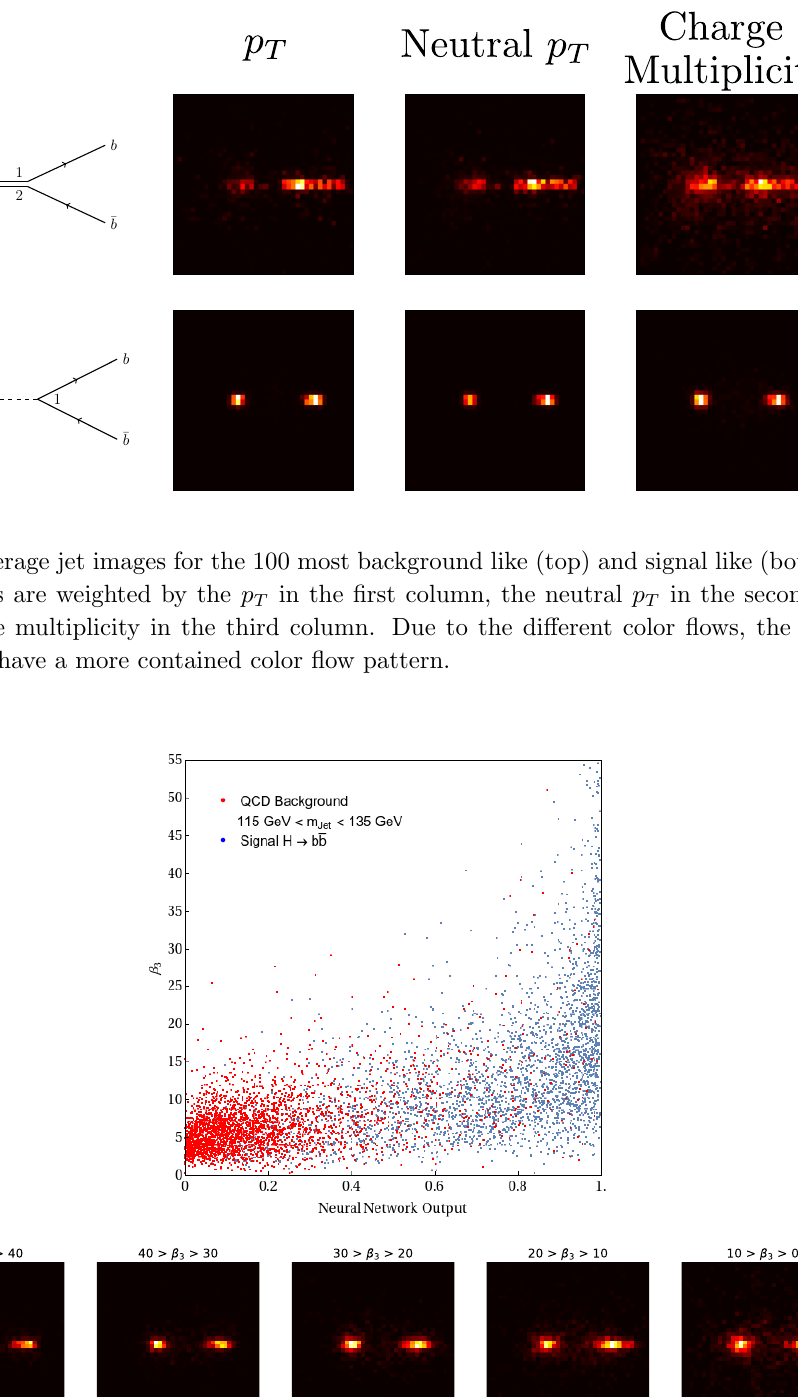
Figure 7 . Color flow for H ! b ¯ b and g ! b ¯ b , the main irreducible QCD background to our signal. The numbers 1 and 2 label di ff erent color lines.